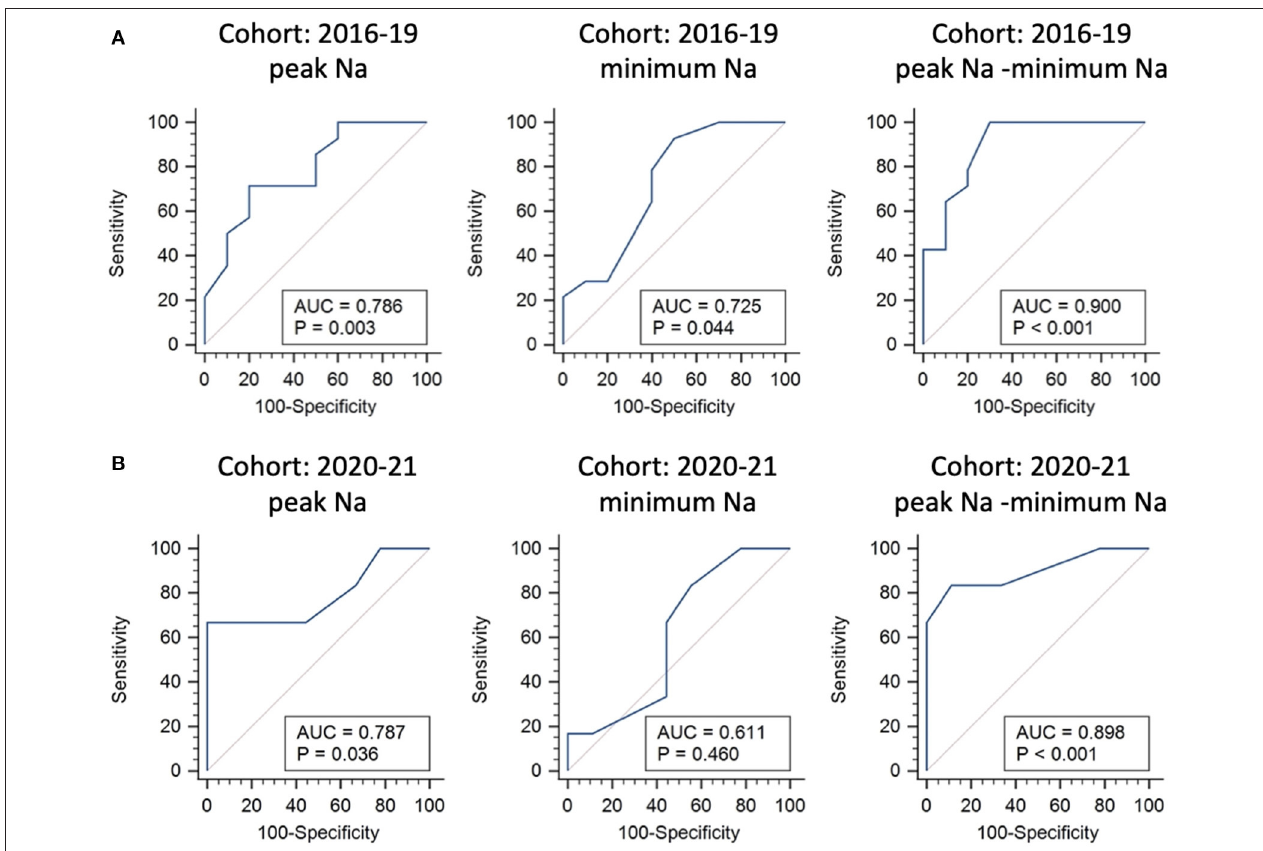
FIGURE 2 | Internal and external validations for predictors of requiring desmopressin prescription after hospital discharge following endonasal endoscopic approach. Receiver operating characteristic curve analysis using the 2016–2019 cohort for internal validation (A) and 2020–2021 cohort for external validation (B) .